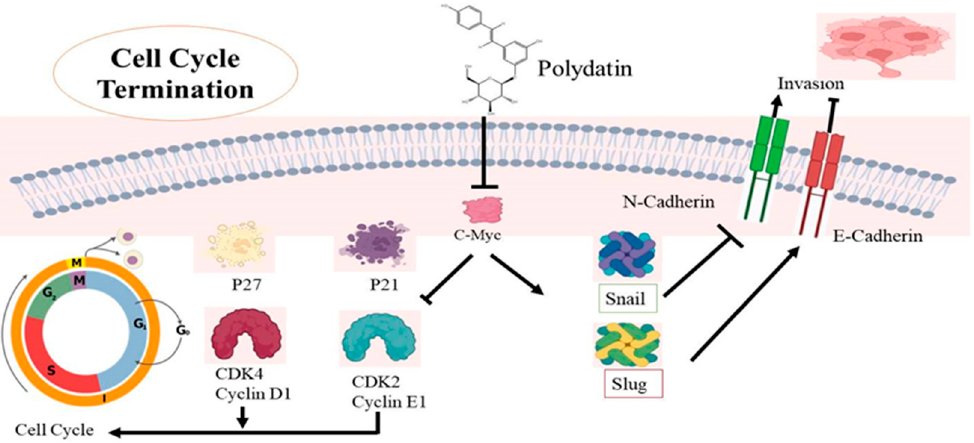
Figure 5. The mechanistic approach of polydatin (PD) activity in terminating cell cycle in cervical cancer cells. PD causes the downregulation of the c-Myc gene, which alters two mechanisms involved in cervical cancer. PD causes upregulation of p21 and p27 , and also induces repression of CDK4 and cyclin D1 as well as CDK2 and cyclin E1 ; their dysregulation ultimately terminates the G0/G1 phase of the cell cycle. In the second pathway, PD causes Snail and Slug expressions, leading to upregulation of E-cadherin expression and downregulation of N-cadherin, and thus impairing cell metastasis in cervical cancer. Table 2. Anticancer activity of polydatin on different types of cancer.